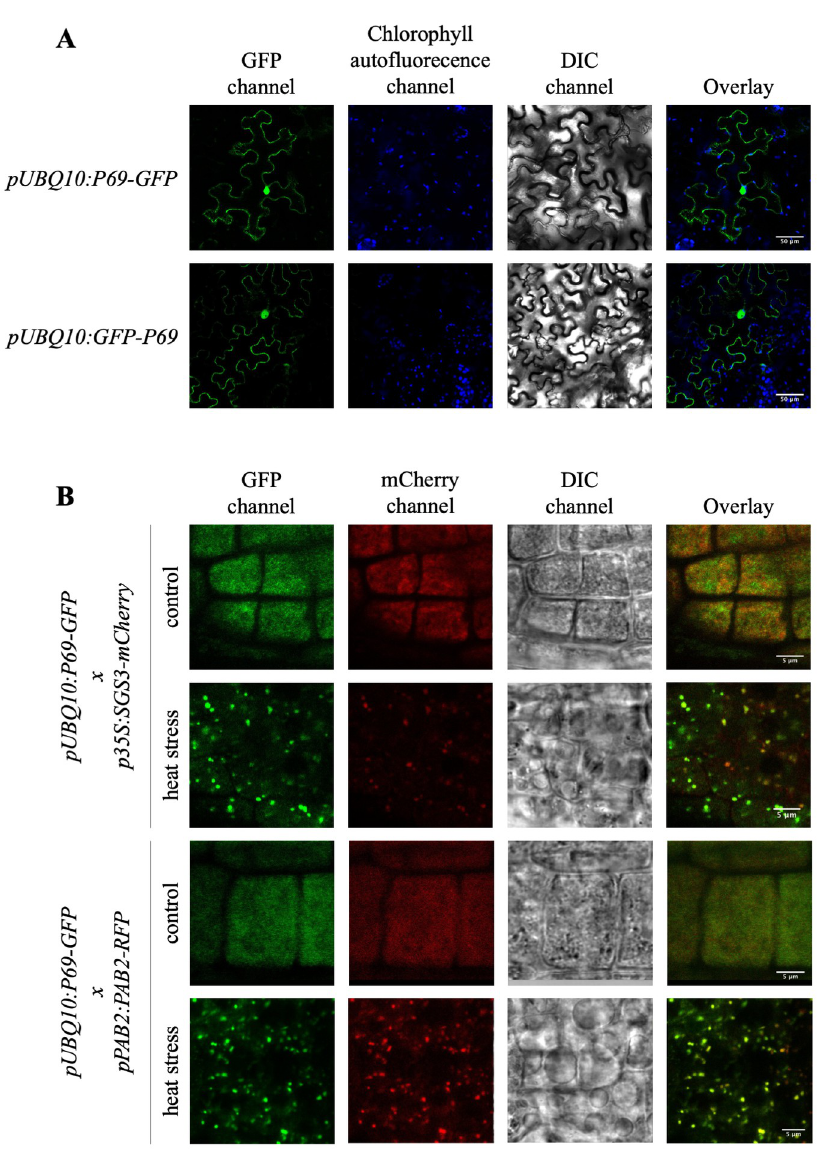
Fig 5. The TYMV protein P69 colocalizes with SB and/or SG under stress condition in Arabidopsis thaliana . A) Nicotiana benthamiana leaves agroinfiltrated with pUBQ10 : P69-GFP or pUBQ10 : GFP-P69 constructs. GFP (green) and chlorophyll auto-fluorescence (blue) signals were analyzed by confocal microscopy 2 days post-agroinfiltration. The overlay corresponds to the merge between the two signals. Channels are indicated above each column and scale bars (50 μ m) are indicated on the overlay. DIC: Differential Interference Contrast. B) Subcellular localization of GFP, RFP and mCherry determined before and after a heat stress of 1h at 37˚C in 5 days old transgenic Arabidopsis thaliana lines pUBQ10 : P69-GFP crossed with p35S : SGS3-mCherry or pPAB2 : PAB2-RFP lines. The overlay corresponds to the merge between the GFP and the RFP or mCherry signals. Channels are indicated above each column and scale bars (5 μ m) are indicated on the overlay. DIC: Differential Interference Contrast.